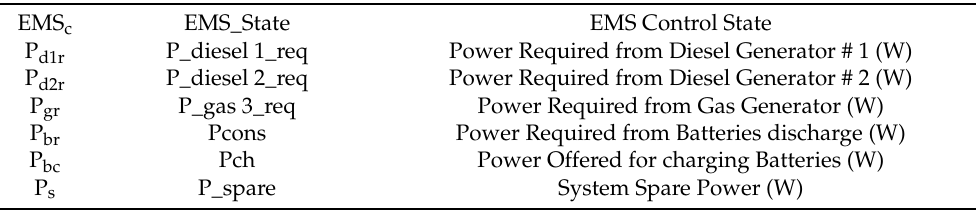
Table 2. Output Variables of EMS (Nomenclature and